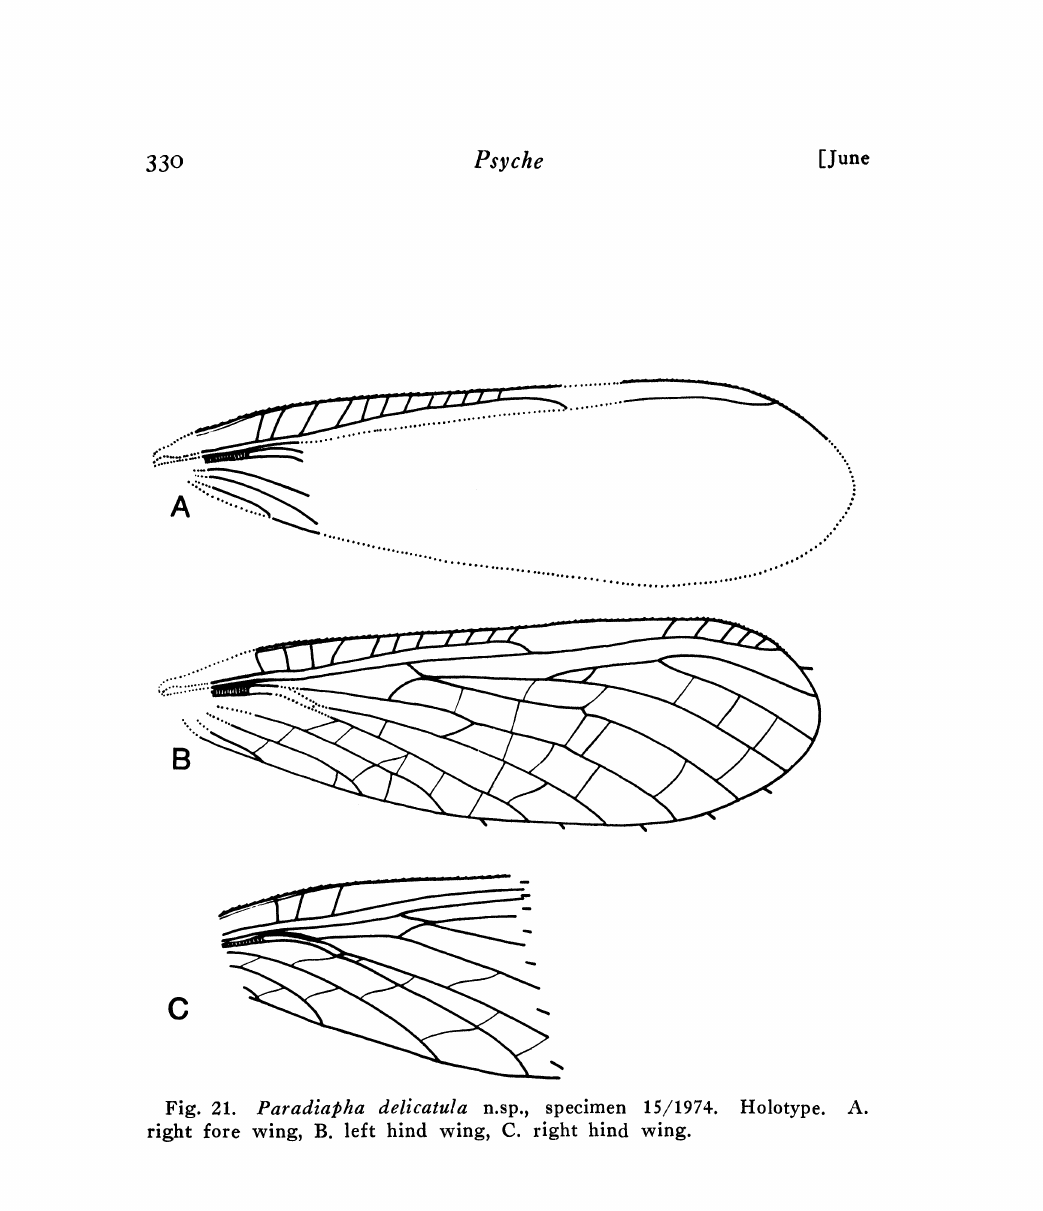
Fig. 21. Paradiapha delicatula n.sp., specimen 15/1974. Holotype. A. right fore wing, B. left hind wing, C. right hind